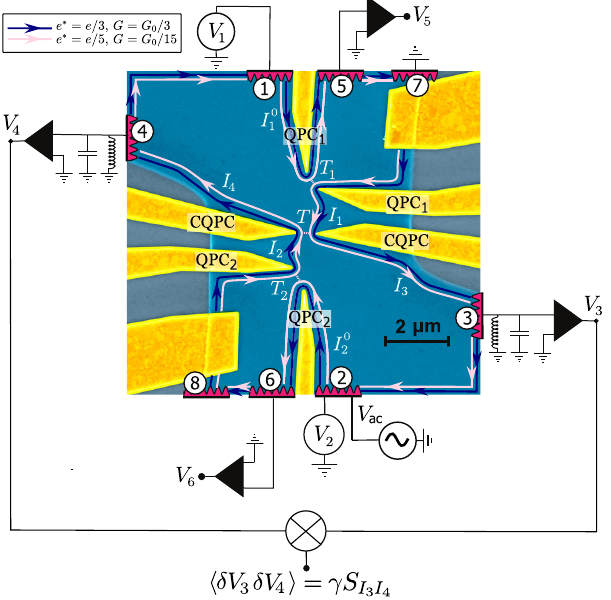
FIG. 1. Anyon collider device. Colored scanning electron microscope picture of the anyon collider device. The two- dimensional electron gas is represented in blue. At filling factor ν ¼ 2 = 5 , charge propagates along two copropagating edge ¼ channels. The inner channel (pink lines) has a conductance G in G = 15 (where G ¼ e 2 =h is the conductance quantum) and the 0 0 ¼ G = 3 . The outer channel (blue lines) has a conductance G 0 out weak backscattering of the inner channel (outer channel) leads to the random tunneling of anyons of fractional charge e (cid:2) ¼ e= 5 ( e (cid:2) ¼ e= 3 ). The dc voltages V 1 and V 2 generate the noiseless currents I 0 1 and I 0 2 toward QPC1 and QPC2 tuned in the weak backscattering regime ( T 1 , T 2 ≪ 1 ). The anyon currents I 1 and I 2 propagate toward CQPC used as a beam splitter of backscattering transmission T . T 1 ( T 2 ) is extracted from the measurements of the small backscattered ac currents δ I 5 ( δ I 6 ) into contact 5 when a small ac voltage δ V 7 ( δ V 8 ) is applied to Ohmic contact 7 (contact ¼ 8). For the inner channel, T 1 ; ( T 2 ; ) is defined by T 1 ; in in in = ð G δ V Þ [ T ¼ δ I = ð G δ V Þ ]. For the outer channel, δ I 5 7 2 ; in 6 8 in in T ¼ ð δ I − G δ V Þ = ð G δ V Þ T 1 ; out is defined by 1 ; out 5 7 7 in out ¼ ð δ I − G δ V Þ = ð G δ V Þ ]. T is extracted from the [ T 2 ; 6 8 7 out in out measurement of the small ac current δ I 3 resulting from the small ac voltage δ V 2 applied to contact 2. For the inner channel, one has T ¼ δ I = ð T G δ V Þ . For the outer channel, one has 3 2 ; in 2 in in T ¼ ð δ I − G δ V Þ = ð T G δ V Þ . Finally, the current cor- 3 2 2 ; out 2 out in out relations S 34 between the currents at the output of the splitter are converted to voltage cross-correlations on RLC tank circuits where R ¼ R K = ν is the Hall resistance. The conversion factor γ is calibrated from thermal noise measurements (see Ref.